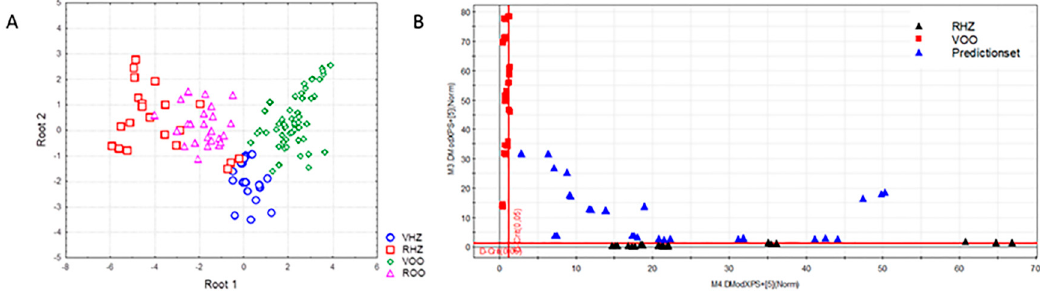
Figure 3. Linear discriminant analysis (LDA) score plot ( A ) and Coomans plot ( B ).